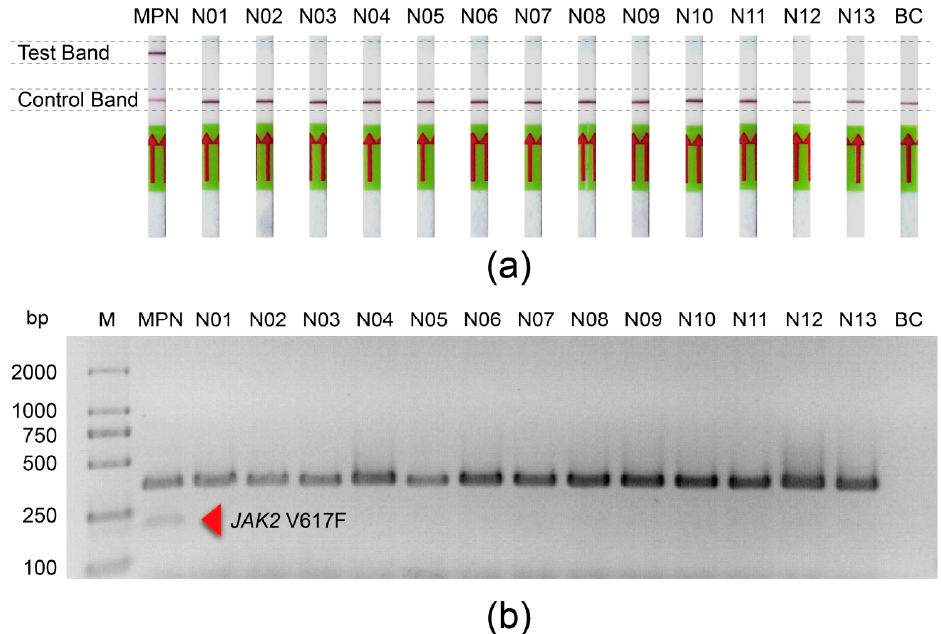
Figure 5. The application of the JAK2 V617F/Cas12a lateral flow strip assay in clinical samples. ( a ) Response signals of the gDNA from 14 clinical peripheral blood samples and a blank control in the JAK2 V617F/Cas12a lateral flow strip assay. Philadelphia-negative myeloproliferative neoplasm (MPN), the patient with essential thrombocythemia; N01–N13, healthy donors; BC, blank control. ( b ) The allele-specific PCR (AS-PCR) results of the gDNA from 14 clinical peripheral blood samples and a blank control. M, GL 2000 DNA maker; MPN, the patient with essential thrombocythemia; N01–N13, healthy donors; BC, blank control.